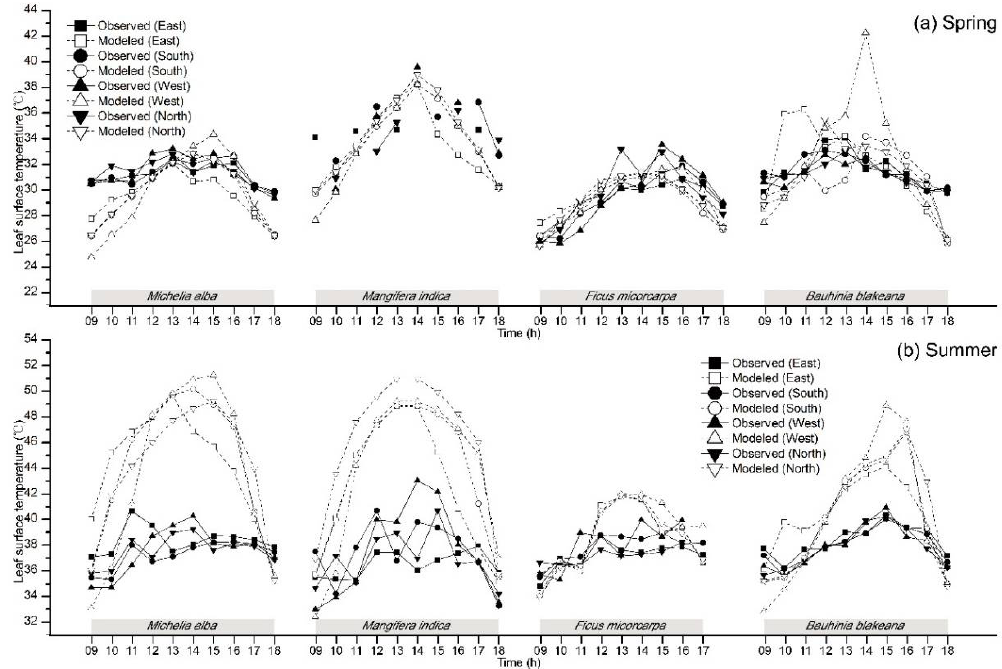
Figure 14. Comparison of modeled and observed leaf surface temperature in four directions: ( a ) in spring; ( b ) in summer. The instrument did not operate properly on the measuring day for Mangifera indica , causing discontinuous observed values. Atmosphere 2018 , 9 , x FOR PEER REVIEW